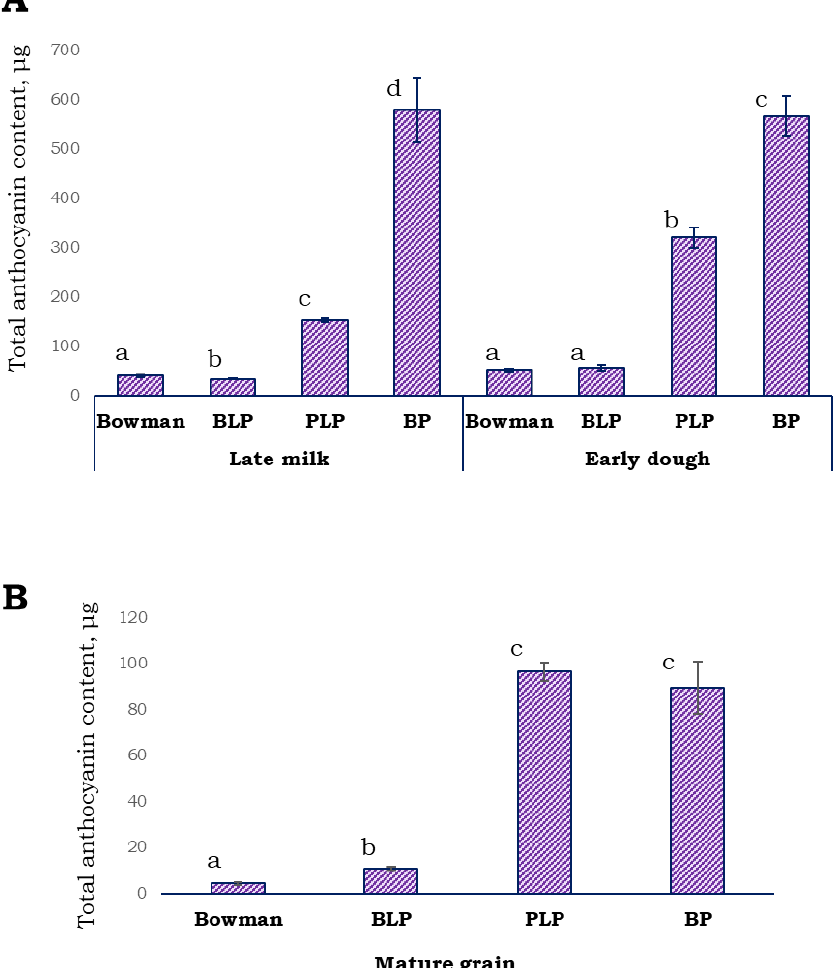
Figure 4. The anthocyanin content expressed in Cy-3-Cly equivalents per gram of DW in the grain pericarp and husk at the late milk and early dough stages of spike development ( A ) and in the whole mature grain ( B ). Different letters indicate statistically significant differences between the lines ( t test, p < 0.05).